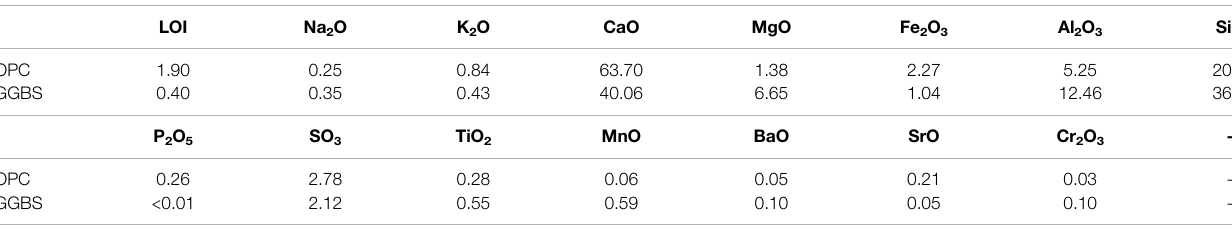
TABLE 1 | Chemical composition of the binder components (ICP-OES, wt%).